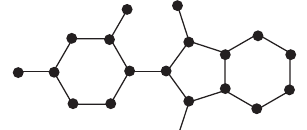
Figure 6: Molecular graph of thalidomide.